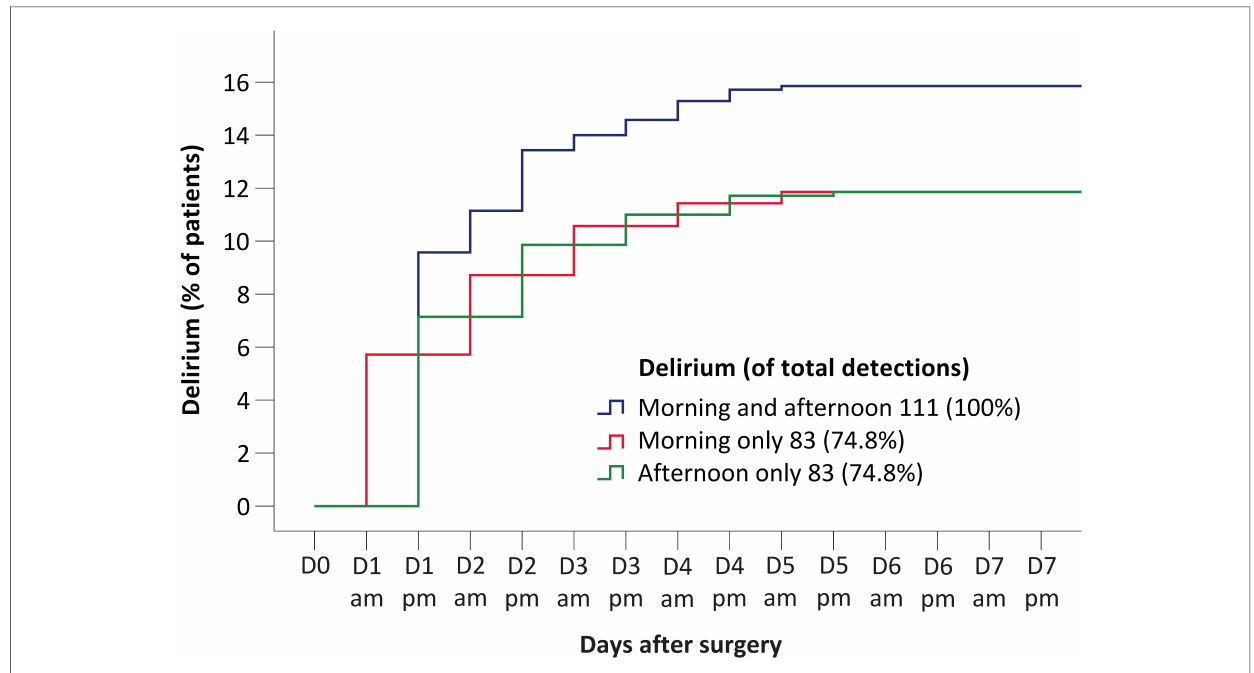
FIGURE 1 Time to onset of delirium using morning and afternoon assessments (blue curve), morning assessments only (red curve), and afternoon assessments only (green curve). Results to the right of fi gure legends indicate the number and fraction of the 111 detected delirium cases identi fi ed with each